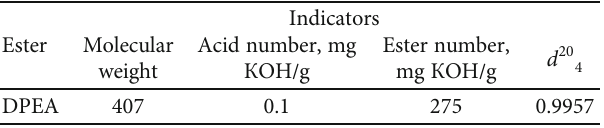
Table 1: Physicochemical properties of decyl phenoxyethyl adipate